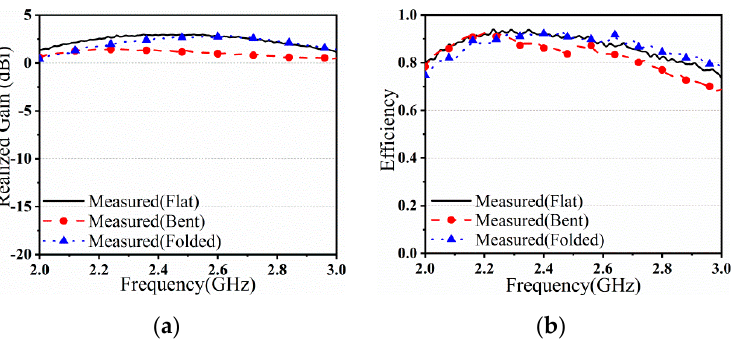
Figure 11. Measurement of the antenna under the flat, bending, and folding states. ( a ) Realized Gain. ( b )